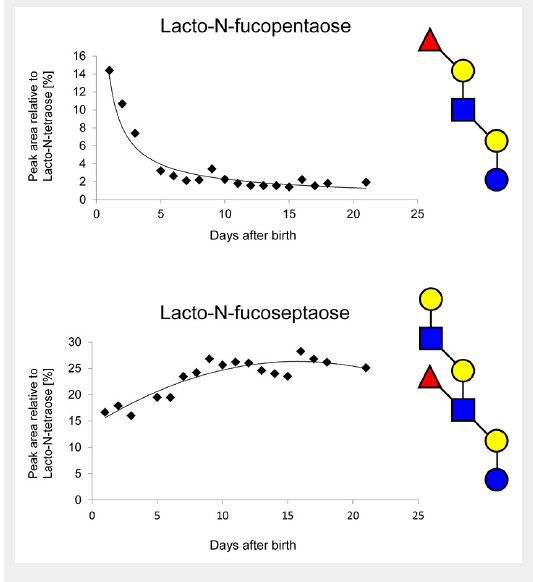
Relative amount of two complex milk oligosaccharides during lactation. The relative levels of the pentasaccharide lacto-N- fucopentaose drop rapidly in the first week of lactation, whereas the relative levels of the heptasaccharide lacto-N-fucoseptaose raise in the first 2 weeks of lactation. Oligosaccharide levels are compared with the constant levels of the milk tetrasaccharide lacto-N-tetraose. The oligosaccharide levels shown were analysed in breast milk samples collected from a single mother over 3 weeks after childbirth.